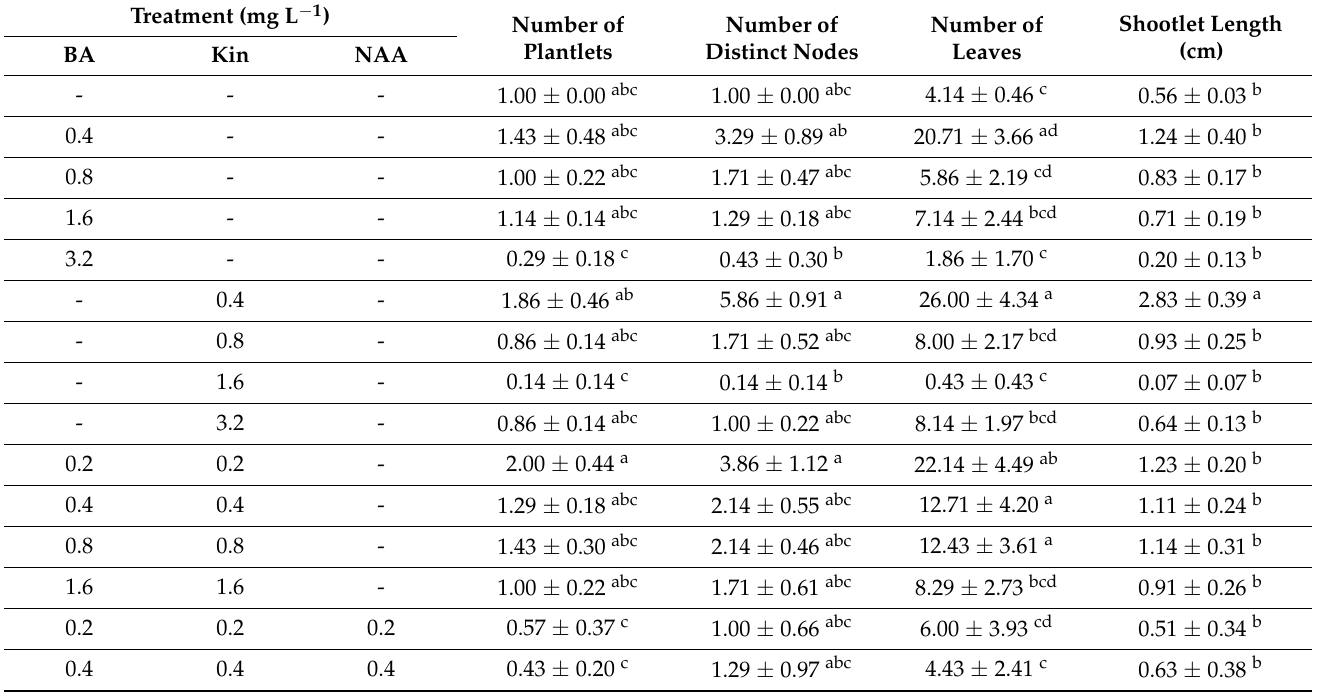
Pairwise comparison was conducted according to the Holm–Sidak method at p ≤ 0.05. Seven replicates were used for each treatment; BA, 6-benzyl adenine; Kin, kinetin; NAA, naphthalene acetic acid. The letters a, b, c, and d represent the pairwise comparison and the significance between